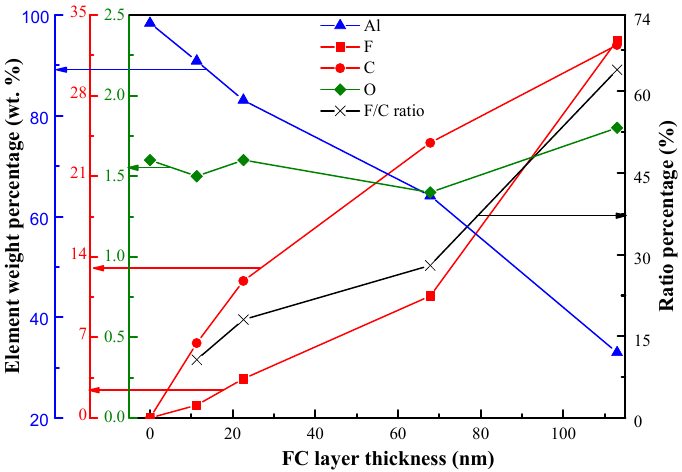
Figure 2. Chemical compositions and F/C ratio of measured samples with difference layer thickness. The lines are for guiding the